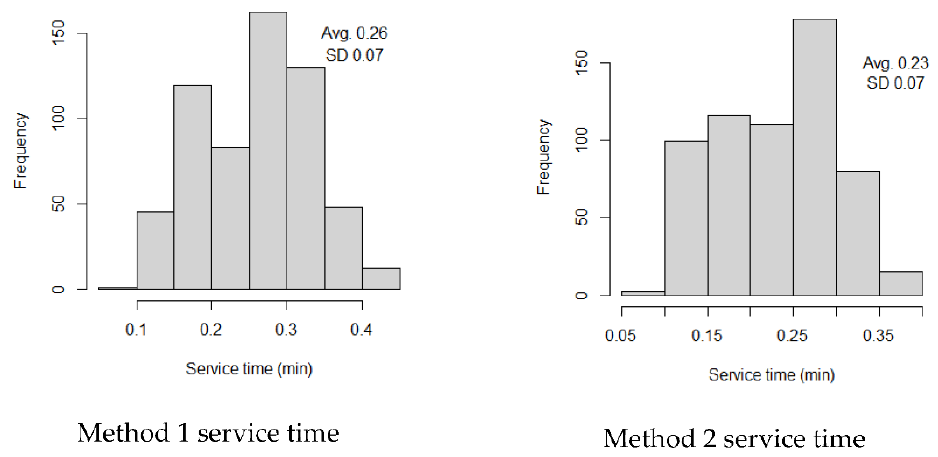
Figure 10. The effect of preparation process on the service time.